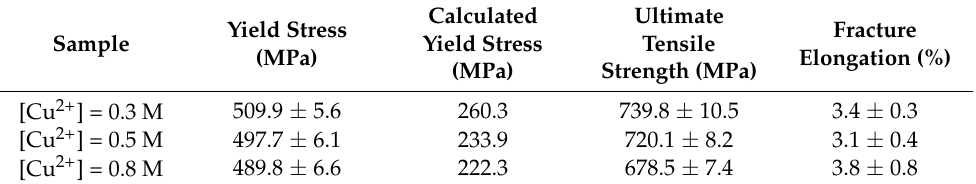
Table 2. Summary of the mechanical properties of the 15- µ m thick nt-Cu foils electroplated with different concentrations of Cu 2+ . The calculated yield stress (YS) was obtained using the classical Hall-Petch equation (Equation